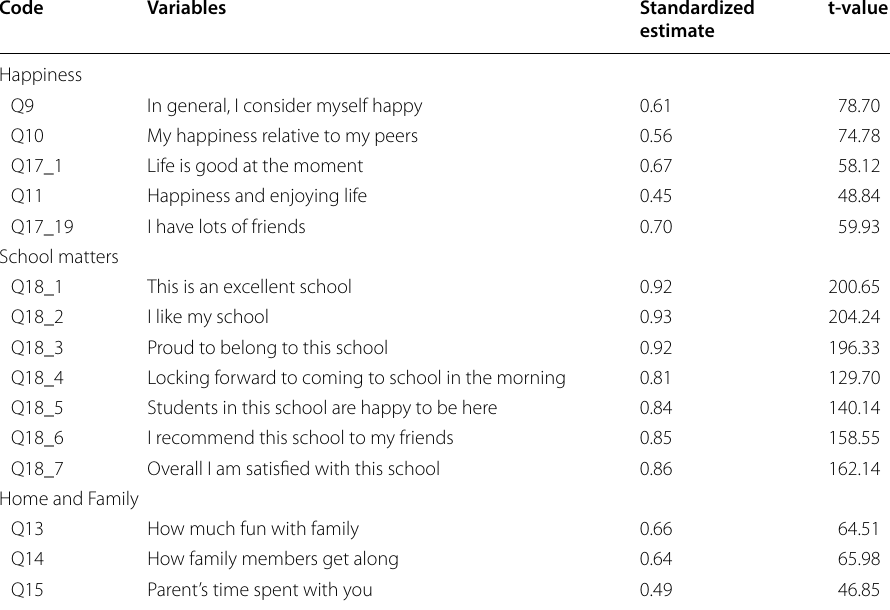
Table 6 Final structural equation model